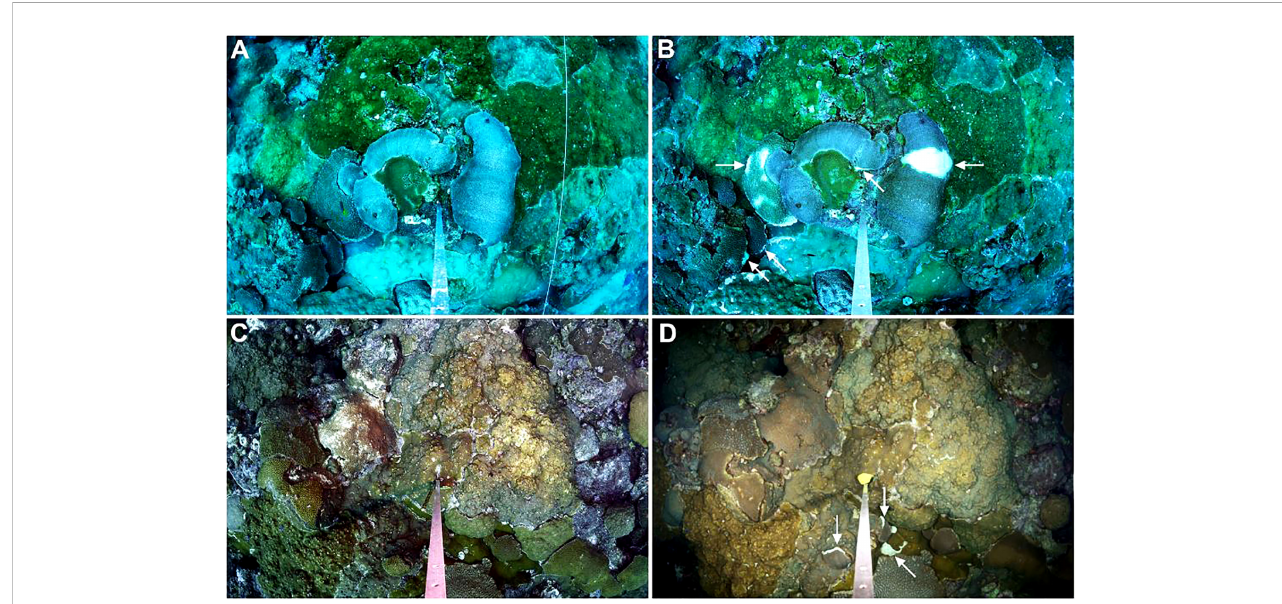
FIGURE 3 Repetitive photostations in 2021 and 2022 at East and West Flower Garden Bank. (A) Repetitive photostation 301 from East Flower Garden Bank (FGB, northwest Gulf of Mexico) with no lesions in 2021 and (B) the same photostation in 2022 with lesions on two Colpophyllia natans colonies, two Pseudodiploria strigosa colonies (larger lesion with fi sh biting), and a C. natans colony with multifocal lesions and bleaching; (C) repetitive photostation 810 from West FGB with no lesions in 2021 and (D) the same photostation in 2022 with lesions on two P. strigosa colonies and an Orbicella franksi colony.